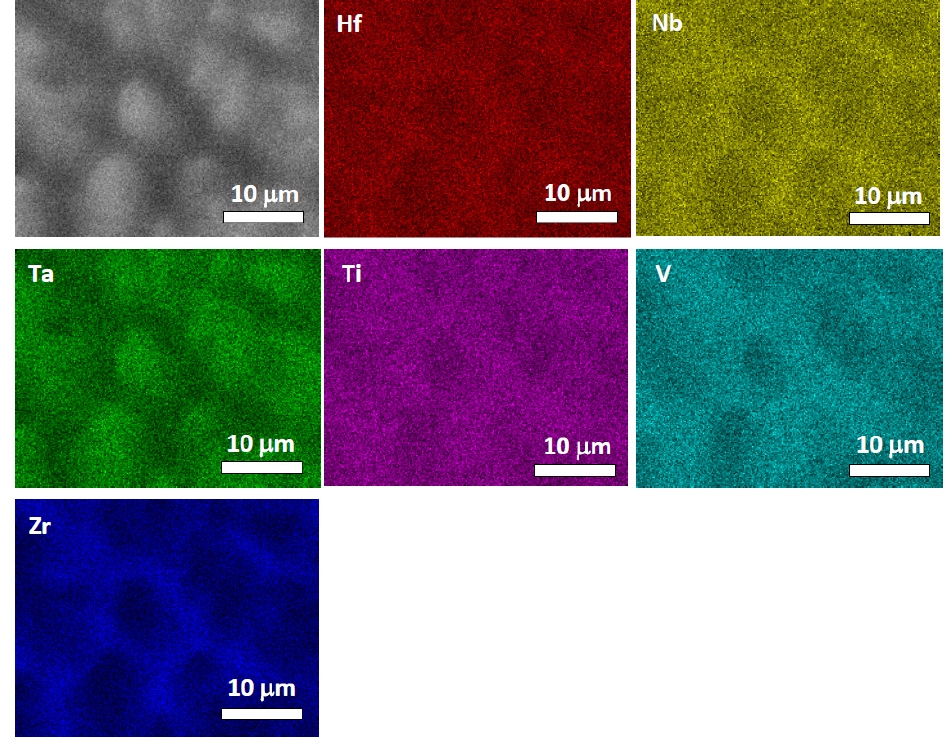
Figure 17. EDS elemental maps of as-cast HfNbTaTiVZr alloy(SEM micrographin the upper left panel shows the inspected region).